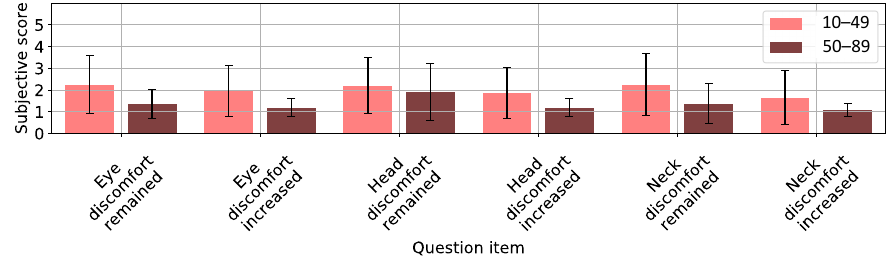
Figure 11. Questionnaire results 15 min after game completion for female participants. The results of Q1 to Q6 are shown from left to right